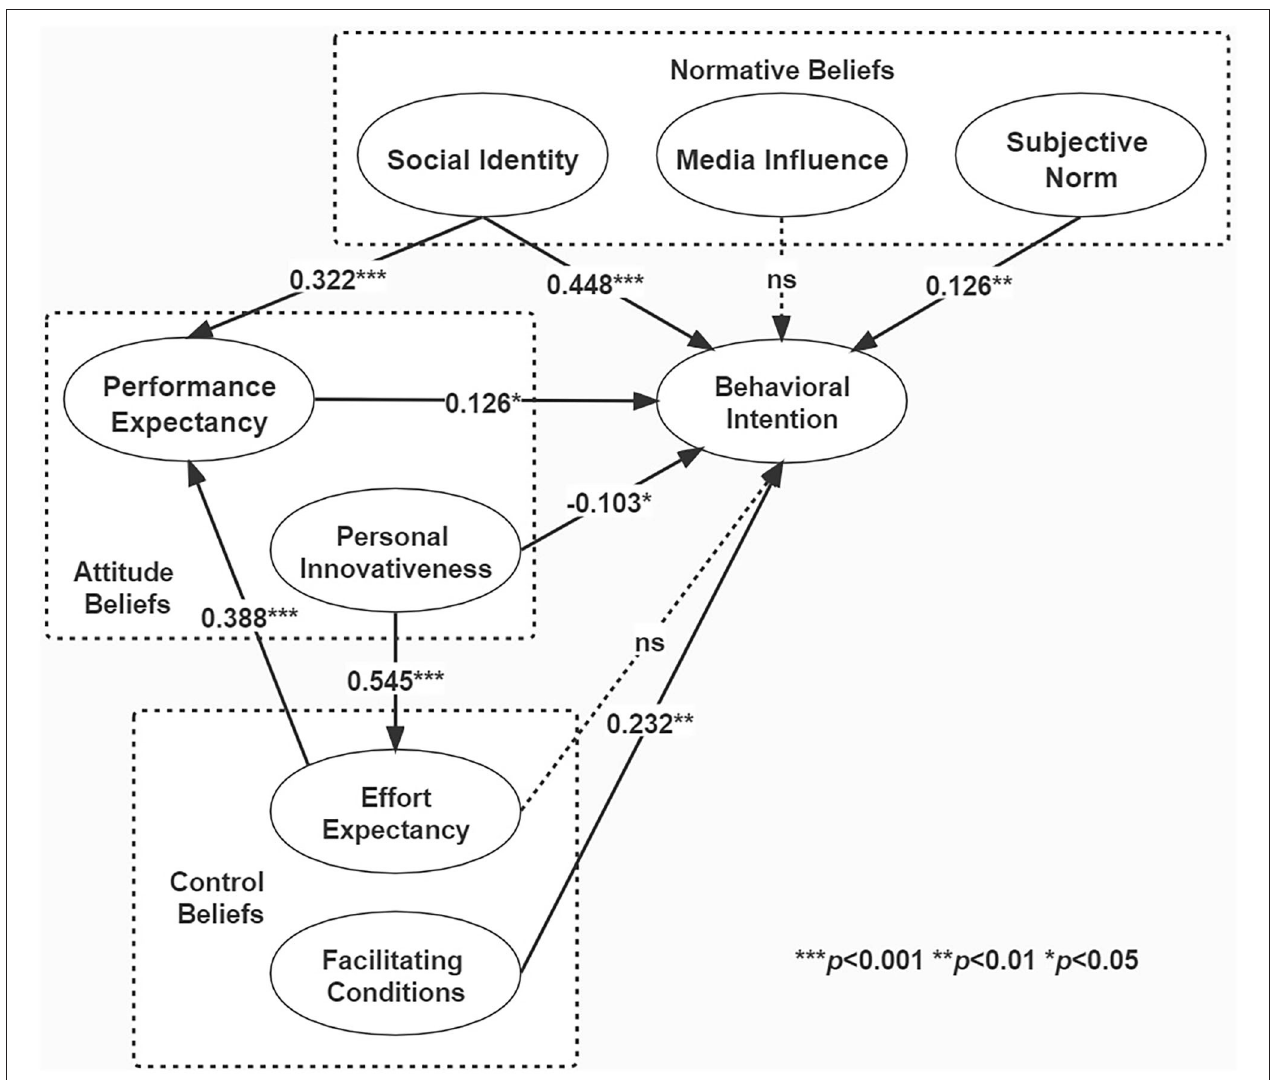
FIGURE 3 | The results of structural model path analysis. ***indicates significance at the 0.001 level; **indicates significance at the 0.01 level, and *indicates significance at the 0.05